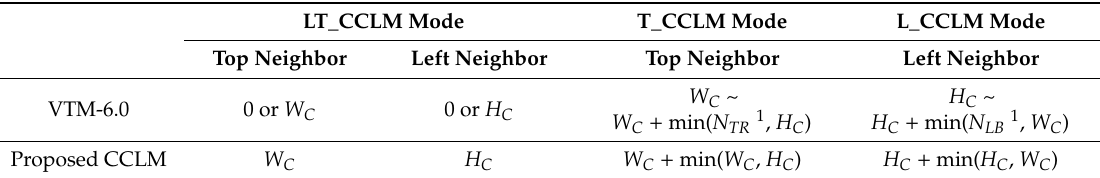
Table 2. Comparison of the lengths of the top and left neighboring chroma samples between VTM-6.0 and the proposed CCLM. LT_CCLM Mode T_CCLM Mode L_CCLM Mode Top Neighbor Left Neighbor Top Neighbor Left Neighbor VTM-6.0 0 or W C 0 or H C Proposed CCLM W C